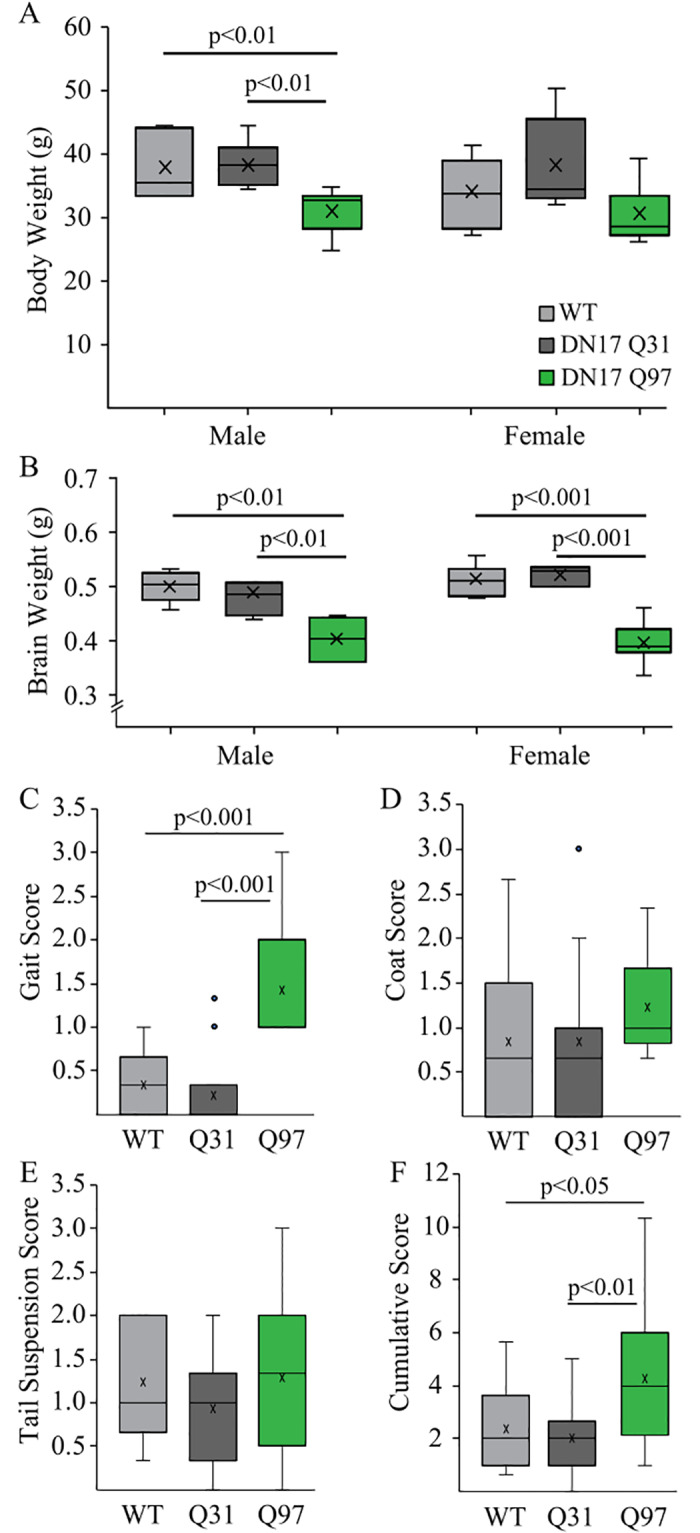
Body and brain weight and motor function in WT, Q31 and Q97 mice. (a) Male Q97 mice weighed significantly less than both Q31 and WT mice, while there was no difference between genotypes in female mice (Male: WT, n = 6; Q31, n = 10; Q97, n = 7; F(2,22) = 8.66, p = 0.002; Female: WT, n = 7; Q31, n = 5; Q97, n = 7; F(2,18) = 2.47, p = 0.116). (b) In both males and females, brain weight was significantly lower in Q97 compared to Q31 and WT subjects (which did not differ, Male: WT, n = 6; Q31, n = 10; Q97, n = 6; F(2,21) = 9.45, p = 0.001; Female: WT, n = 7; Q31, n = 5; Q97, n = 7; F(2,18) = 33.2, p<0.001;). (c) Q97 mice exhibited significantly impaired gait (WT, n = 11; Q31 = 15; Q97 = 11). (d) Coat quality did not differ between groups (WT, n = 13; Q31 = 15; Q97 = 14). (e) Tail suspension score did not differ between groups (WT, n = 13; Q31, n = 15; Q97, n = 14). (f) Cumulative score of animal performance in the motor tasks plus coat quality assessment revealed significant impairment in Q97 mice (WT, n = 13; Q31, n = 15; Q97, n = 14; p-values from posthoc Tukey tests).